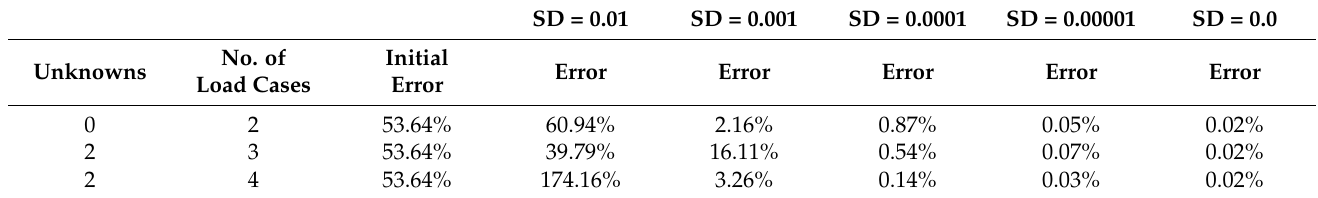
Table 7. Errors obtained for the TMM thermal parameters. Steady state 7 nodes model.